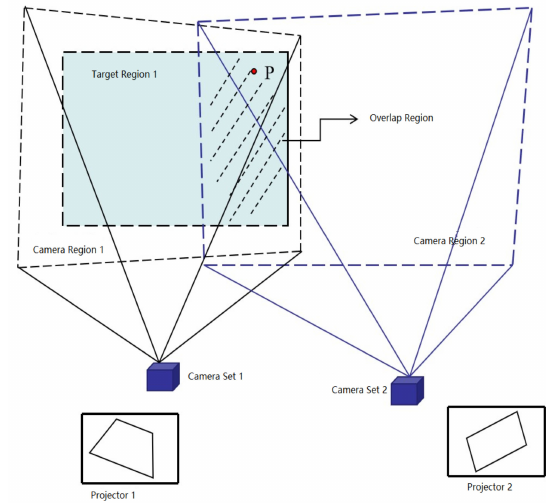
Figure 5. Schematic diagram of projector P1’s projection and binocular cameras C1 and C2 image